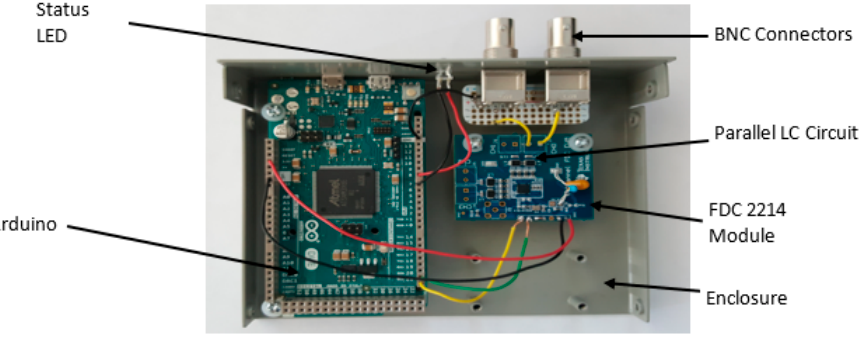
Figure 7. Actual image of the single-channel meter circuit.